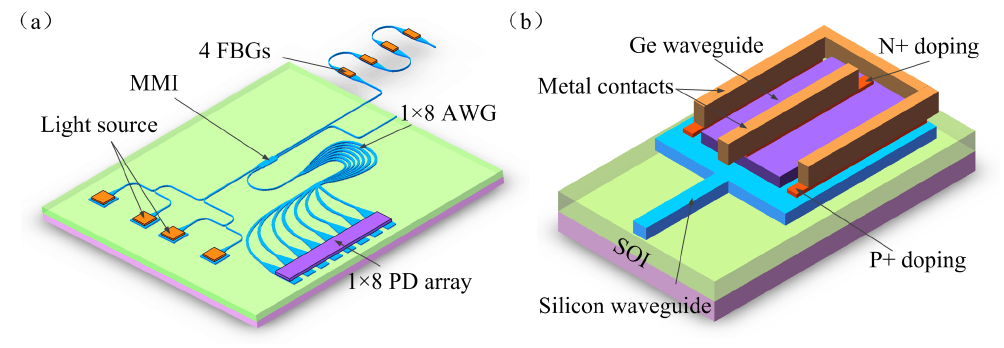
Figure 1. Device structure diagram. ( a ) Schematic of the on-chip arrayed waveguide grating (AWG) interrogator. ( b ) Proposed vertically coupled Ge waveguide